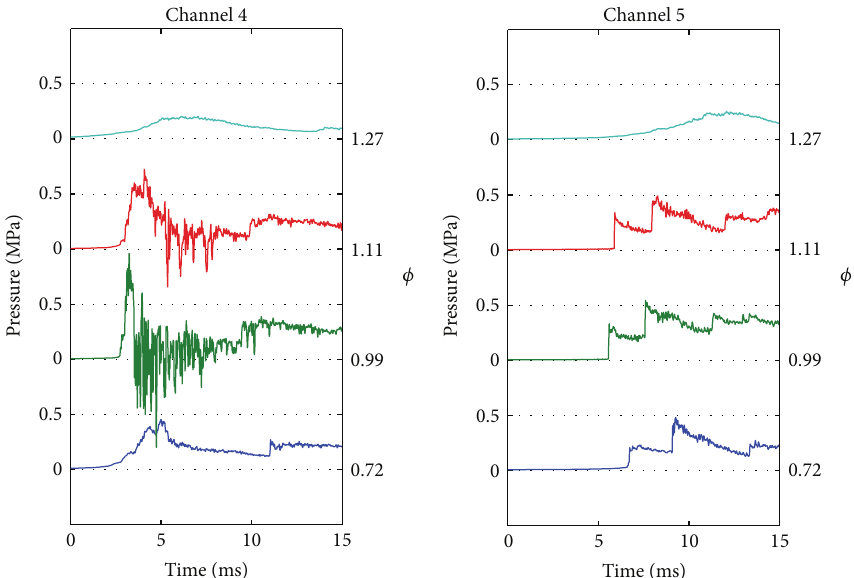
Figure 8: From bottom: tests 24, 23, 25, and 26. Comparison of pressure records from channels 4 and 5 for lean, stoichiometric, and rich NG-air mixtures. Pressure is shown on left vertical axis, while the equivalence ratio is given on the right vertical axis.